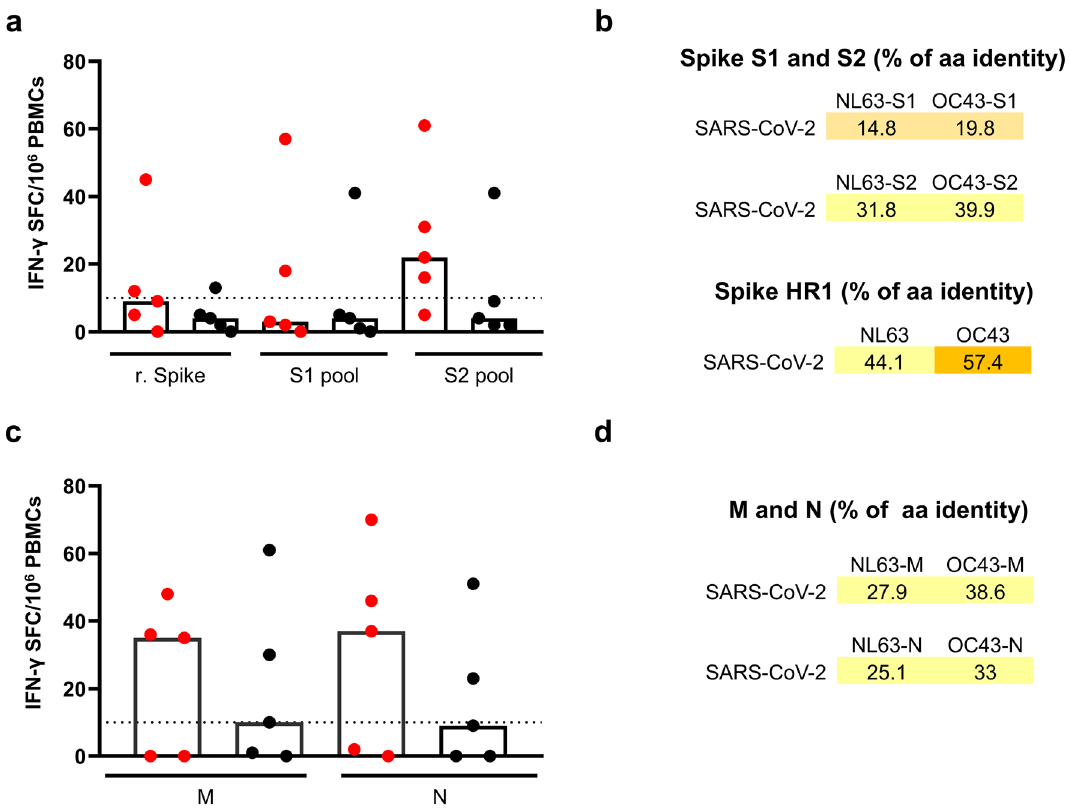
Figure 3. SARS-CoV-2 S, M and N protein cross-reactive T cells in high-responders. PBMCs from 5 young (red dot) and 5 older (black dot) adults high-responders, were cultured in the presence of ( a ) SARS-CoV-2 recombinant Spike protein (2.5 µg/ml) or S1 and S2 peptide pools (1 µg/ml each peptide); ( c ) N and M peptide pools (1 µg/ml each peptide) and frequency of IFN-γ producing T cells measured by ELISpot. Data were background-subtracted and expressed as SFC/10 6 PBMCs. Each dot represents a single subject and columns the median. Percentage of amino acids homology between the SARS-CoV-2 and HCoV NL63 and OC43 for: ( b ) S1, S2 and heptad repeat 1 (HR1), ( d ) M and N.